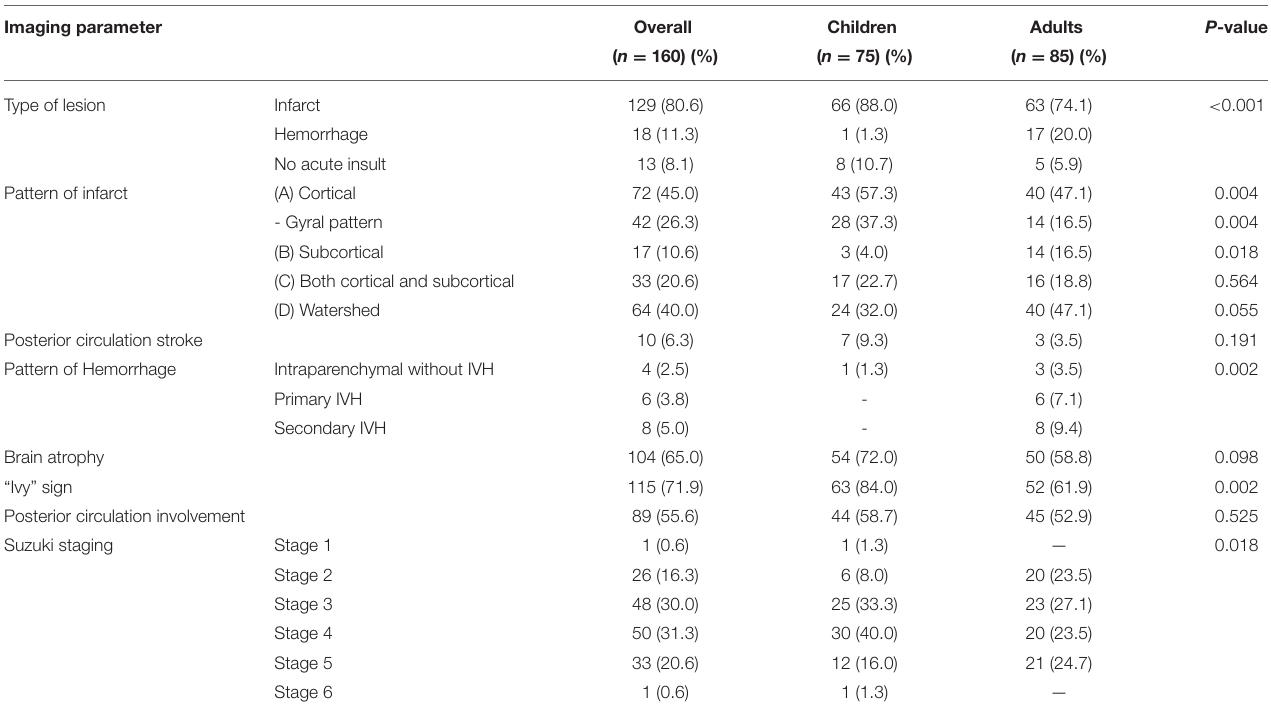
TABLE 6 | Radiological characteristics of MMA patients.